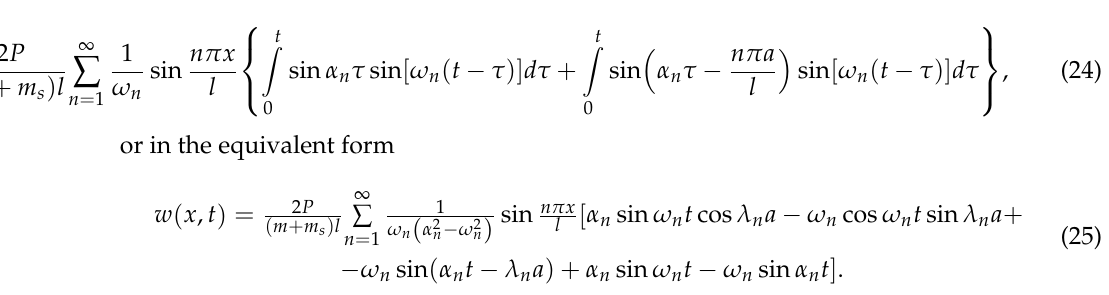
or in the equivalent form The solution to the equation of motion (Equation (23)) can be written using Duhamel integrals